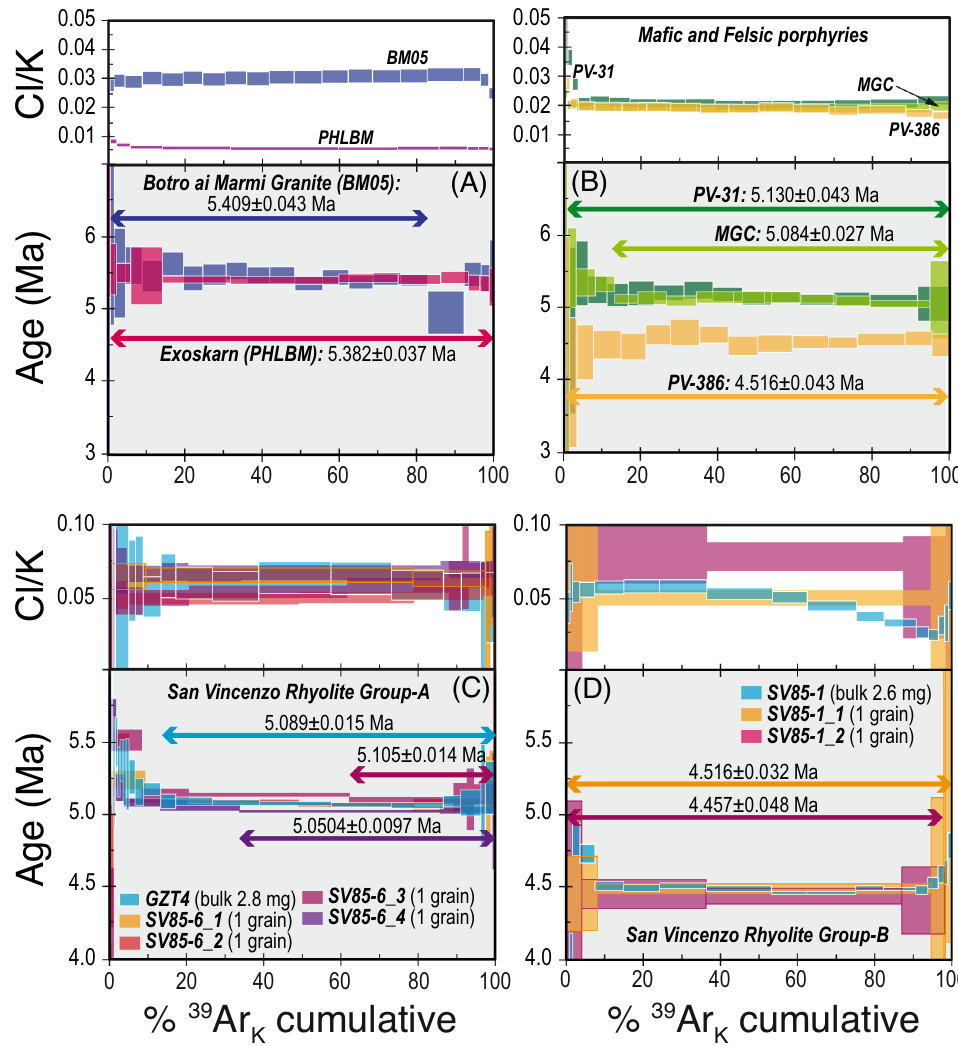
Figure 4. Age and Cl/K (derived from neutron-produced 38 Ar Cl / 39 Ar K ratio) spectra from step-heating experiments of trioctahedral mica separates. Box heights indicate the 2σ analytical uncertainty. ( A ) Biotite from Botro ai Marmi Granite and phlogopite from the exoskarn. ( B ) Biotite from mafic and felsic porphyries. ( C ) Multi-grain and single-grain step-heating experiments on biotite from Group-A of the San Vincenzo Rhyolite. ( D ) Multi-grain and single-grain step-heating experiments on biotite from Group-B of the San Vincenzo Rhyolite. Biotite analyses from Botro ai Marmi Granite, exoskarn and mafic and felsic porphyries were obtained on ~ 10 mg of mineral separate through a single-collector noble gas mass spectrometer. Data on biotite separates from San Vincenzo Rhyolite were obtained using a multi-collector noble gas mass spectrometer on single grains or on ≤ 3 mg of mineral